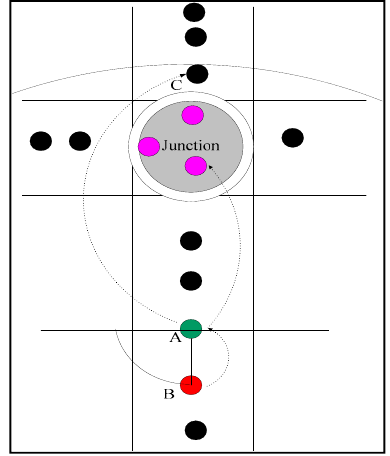
Figure 7. Greedy Forwarding vs. Restricted Greedy Forwarding of Greedy Perimeter Coordinate Routing (GPCR).